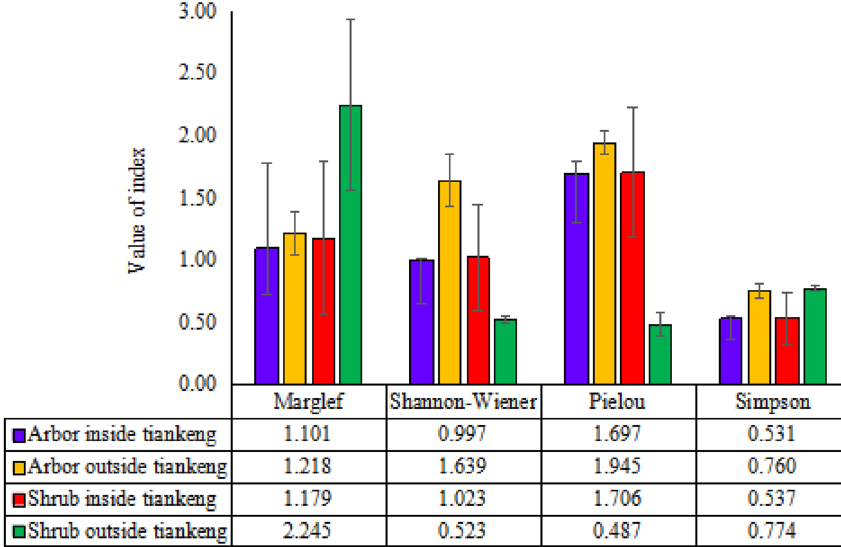
Figure 5. Community diversity comparison between inside tiankeng and outside